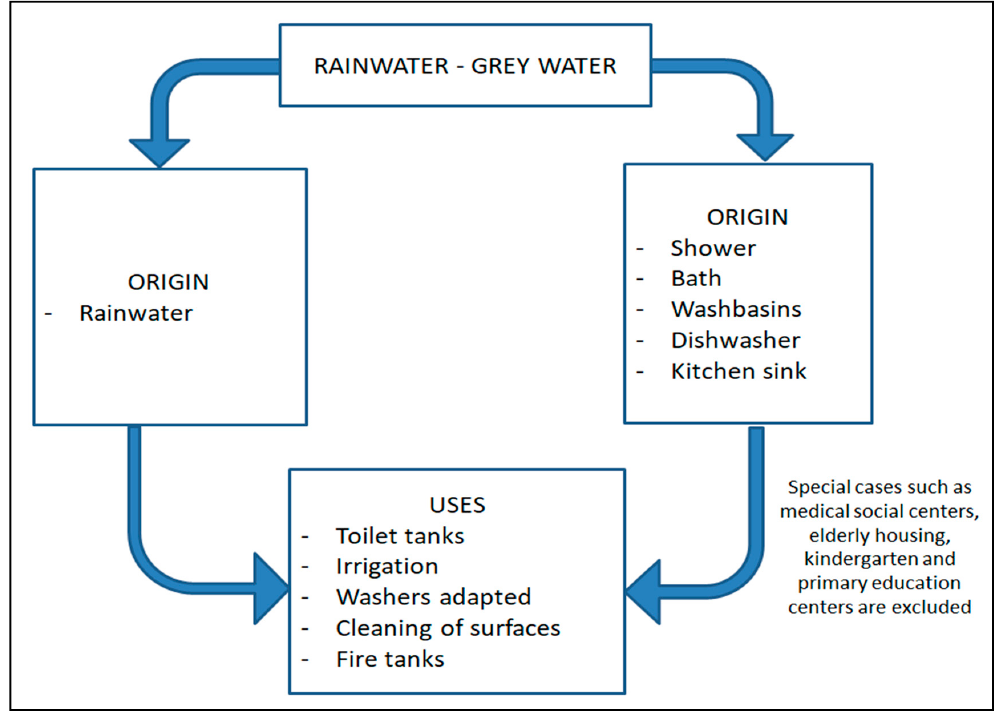
Figure 6. Origin and uses of rainwater and grey water [47,49].